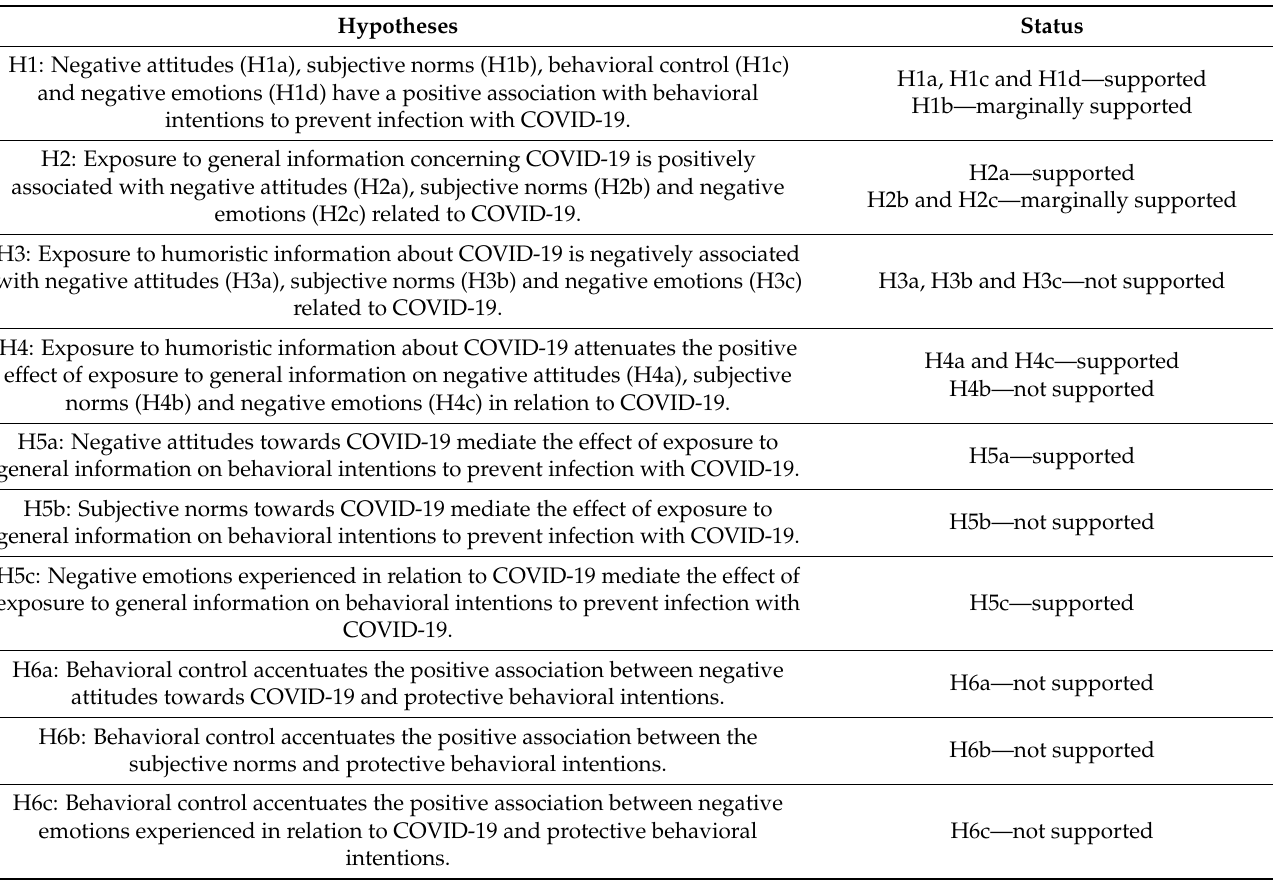
Table 5. An overview of the hypotheses tested in the